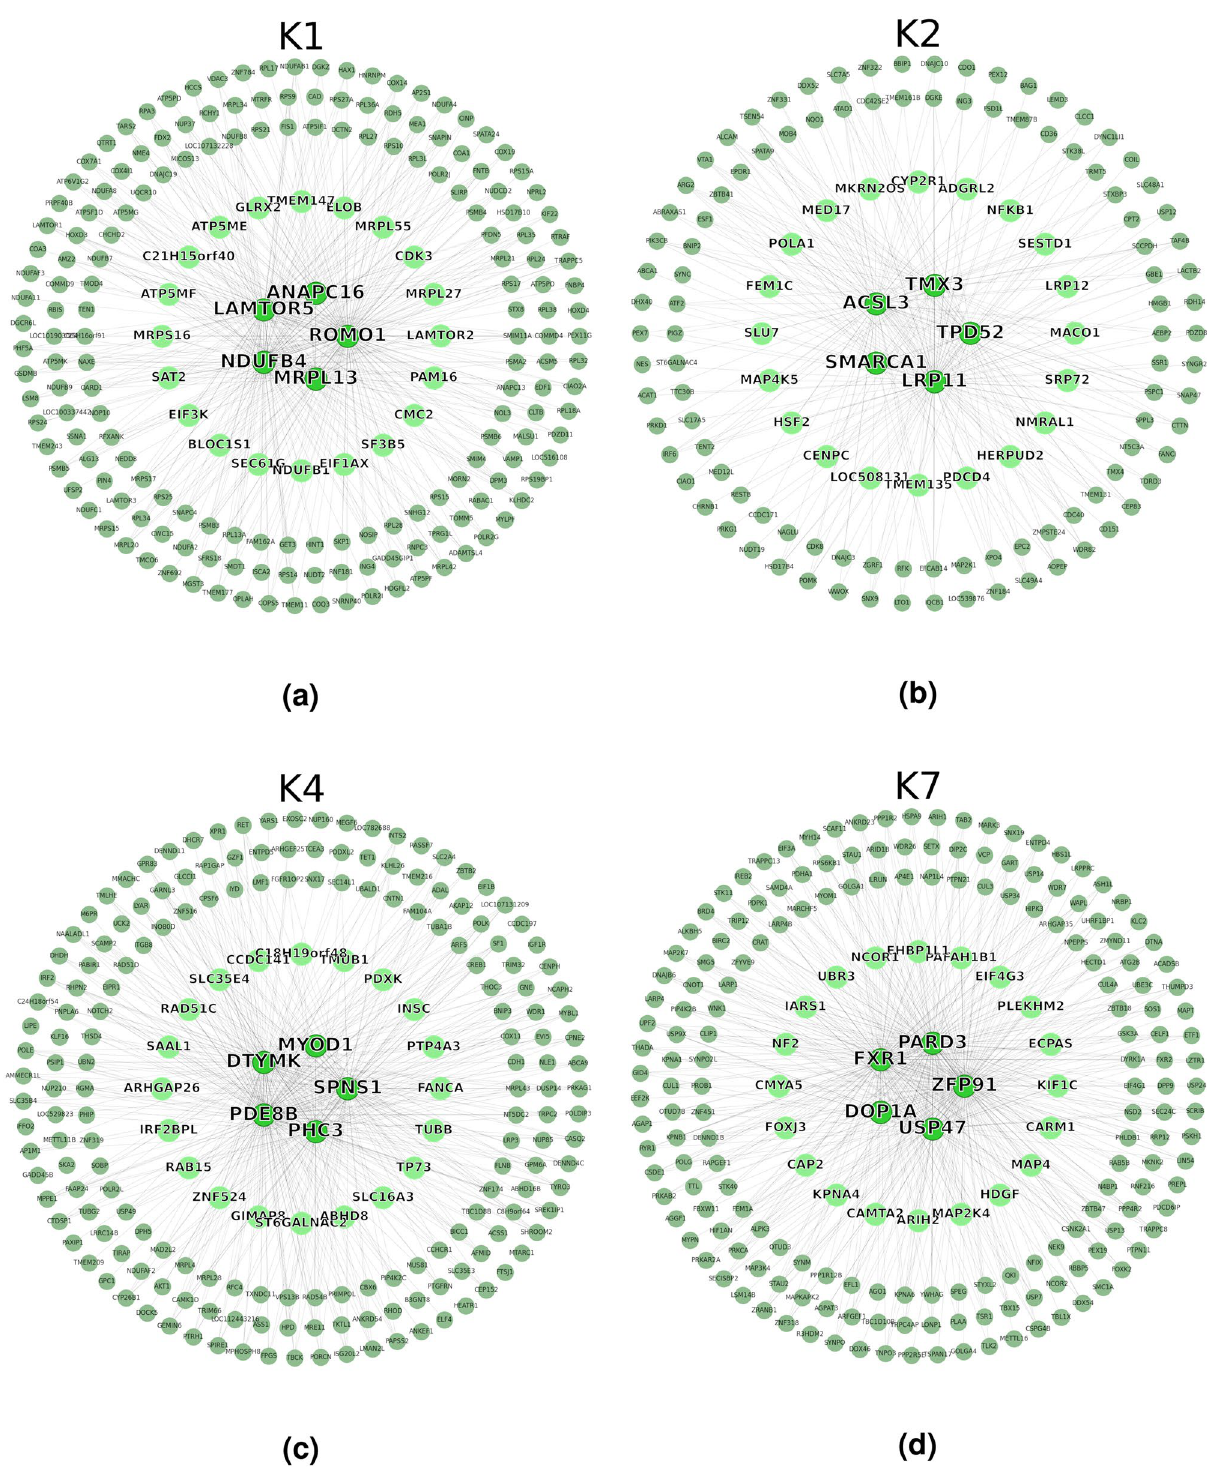
Figure 6. Hub gene networks of the four principal modules of native Korean cattle: ( a ) K1, ( b ) K2, ( c ) K4, ( d ) K7. From the outside in, the top 200, top 25, and top 5 hub genes are shown. The linkages of the top 5 hub genes are shown as the edges of the